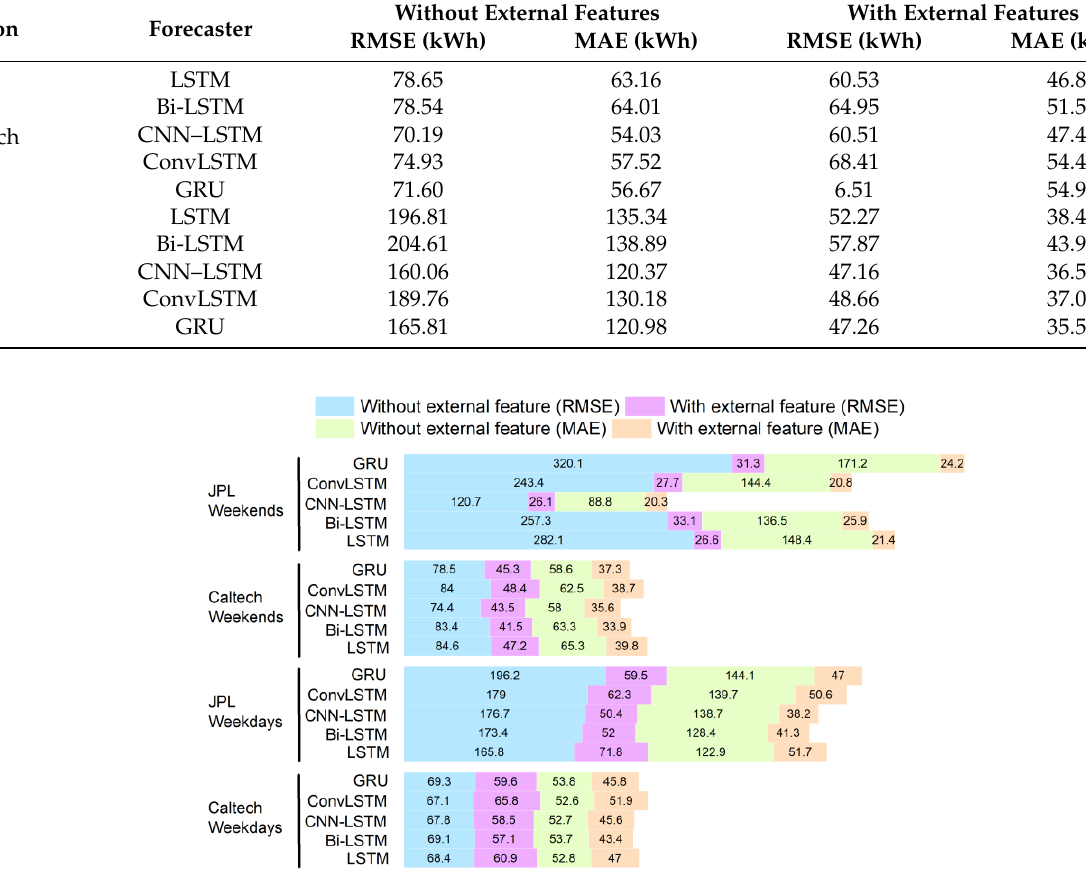
Figure 8. Forecasting performance on weekdays and